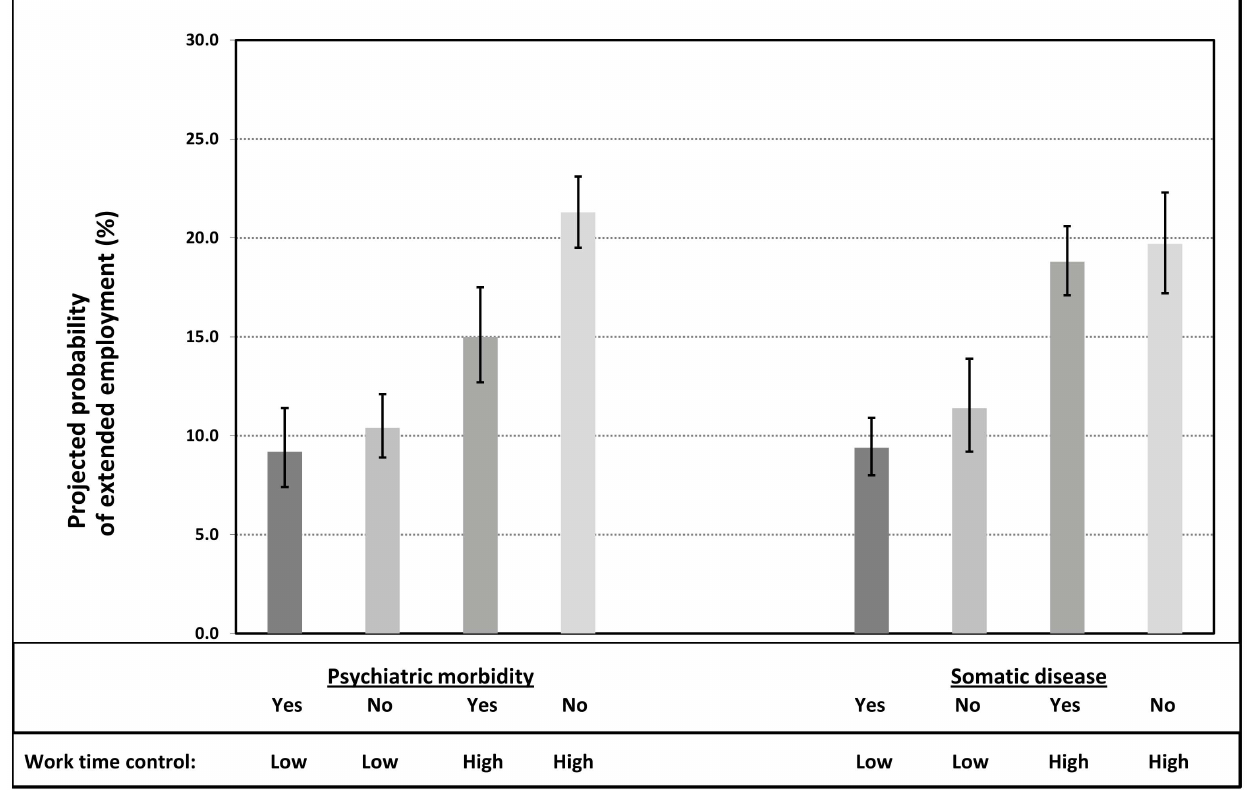
Figure 2. Projected probability (%) and 95% confidence intervals for extended employment at . 6 months beyond the pensionable age by psychiatric and somatic morbidity and work time control, multivariable adjusted